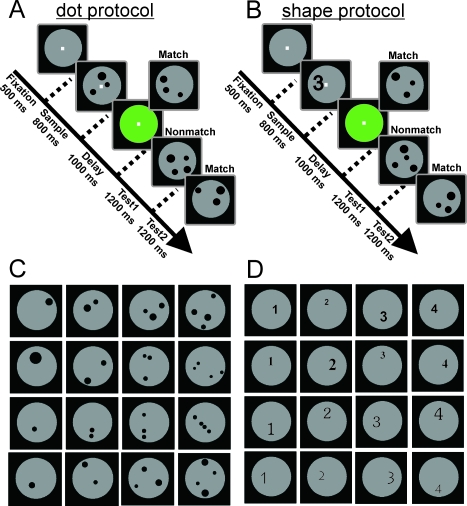
Task Protocols(A) Dot protocol designed as delayed match-to-sample task. The monkeys were required to release a lever if sample and test displays contained the same number of items, or to keep holding it otherwise (probability = 0.5). The dots' position and size were varied between sample and test display and changed in each trial.(B) Shape protocol designed as delayed association task. Task conditions were identical to those of the dot protocol, but during the sample period the numerical information was cued by an Arabic numeral. The numerals' size and position changed in each trial.(C and D) Standard (first row) and control (second to fourth row) stimuli. (C) In the dot protocol, we controlled for non-numerical cues (dot circumference, area, configuration, and density). (D) Four different fonts (“Arial” in the standard protocol; “Times New Roman,” “Souvenir BT,” and “Lithograph Light” in the controls) were presented in the shape protocol.